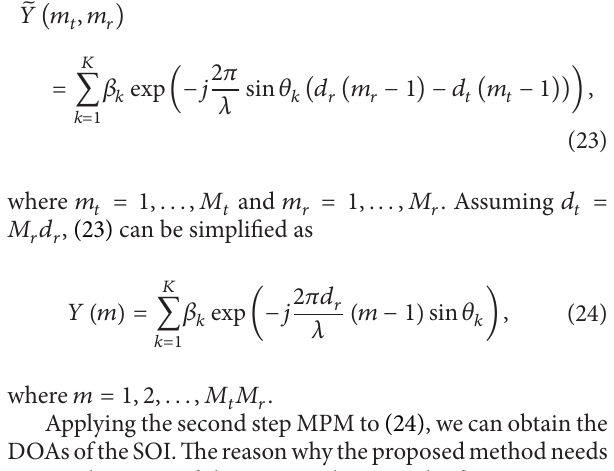
Figure 1 is simulation geometry for collocated MIMO